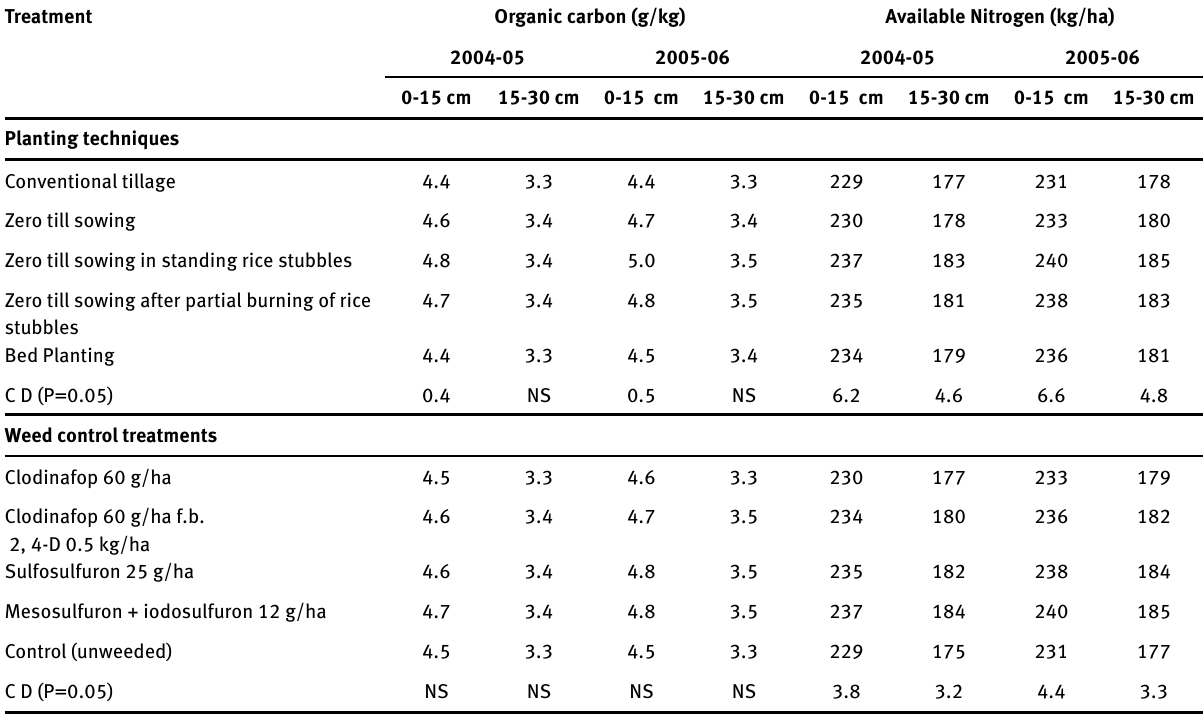
Table 2: Influence of planting techniques and weed control treatments on organic carbon and available nitrogen in soil